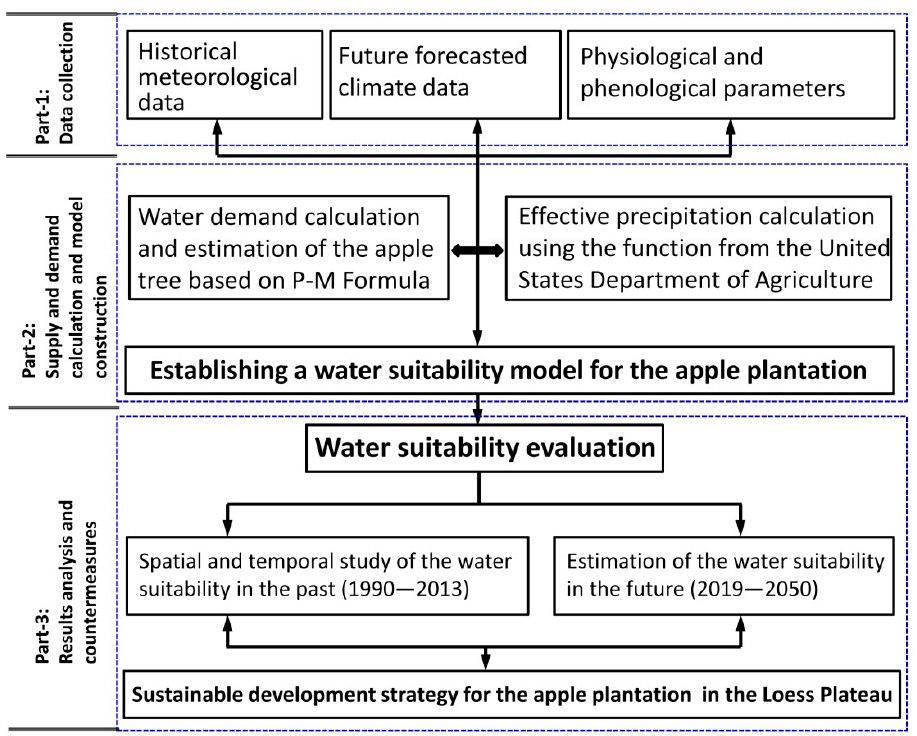
Figure 2. Technical roadmap of this study.